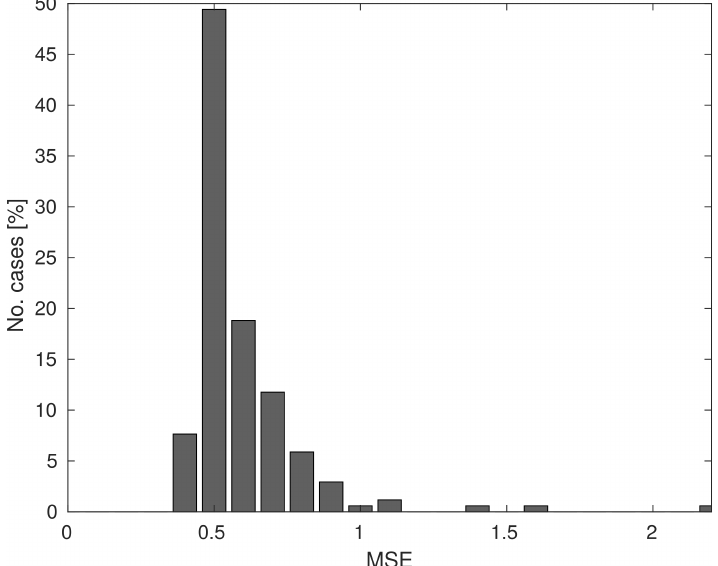
Figure 4. Mean square error (MSE) histogram of Monte Carlo test for real parathyroid